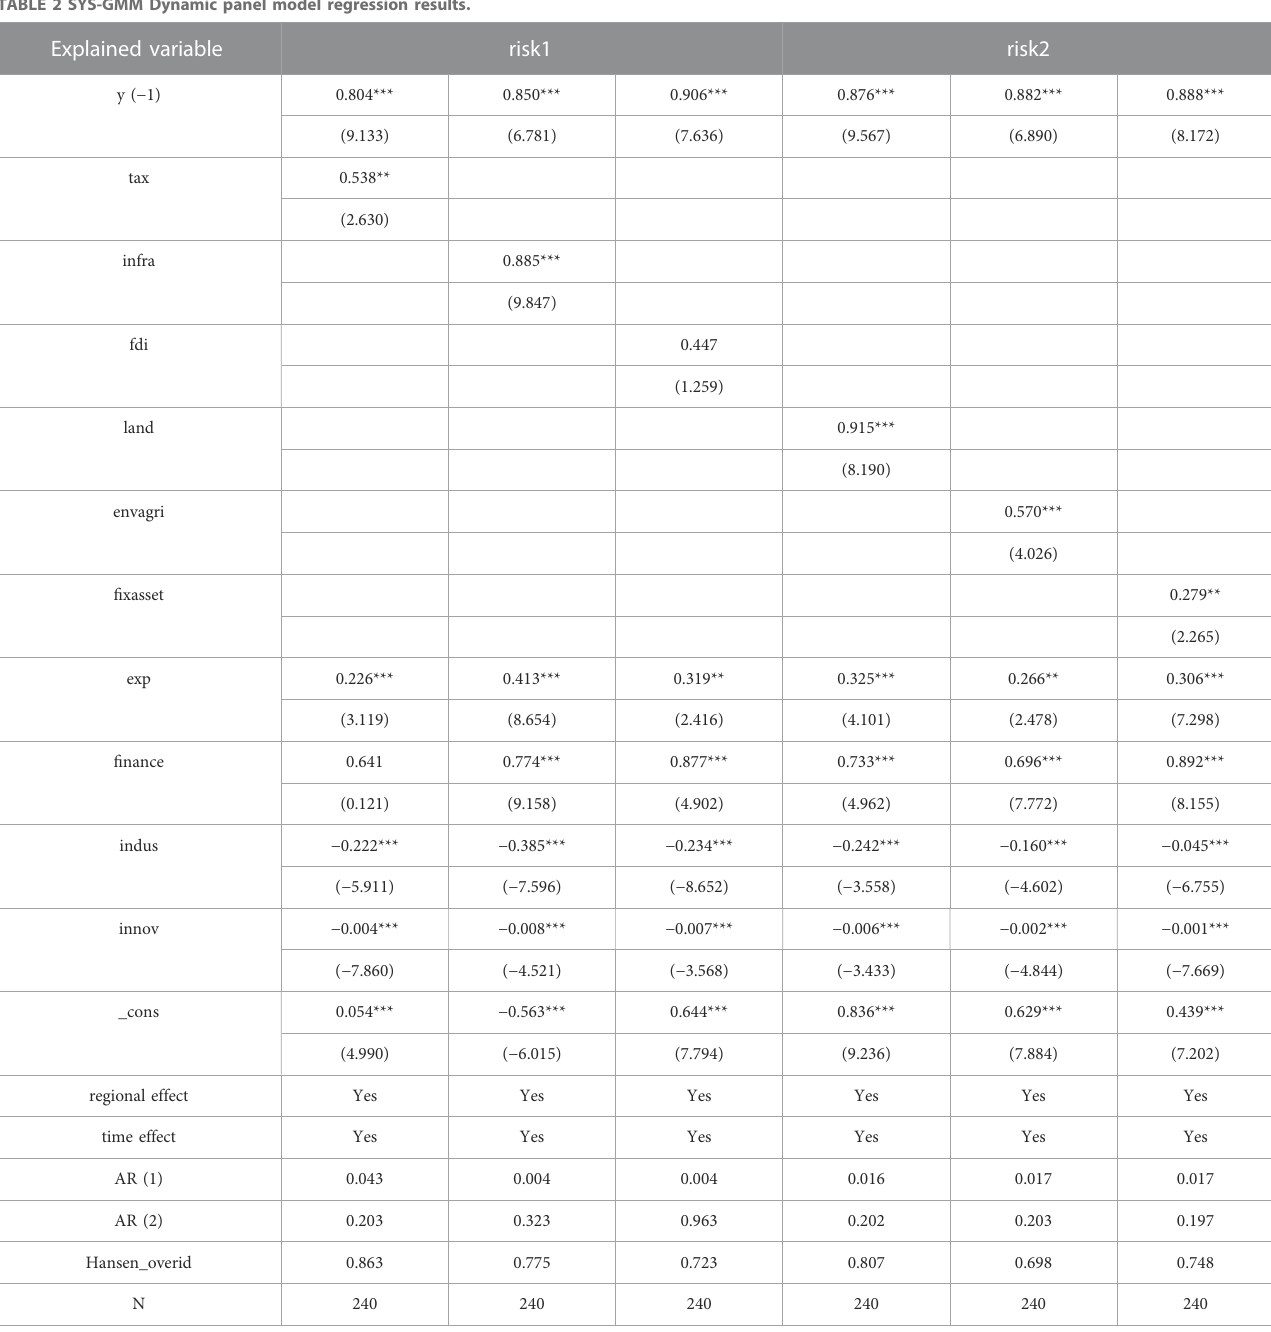
TABLE 2 SYS-GMM Dynamic panel model regression results. Explained variable